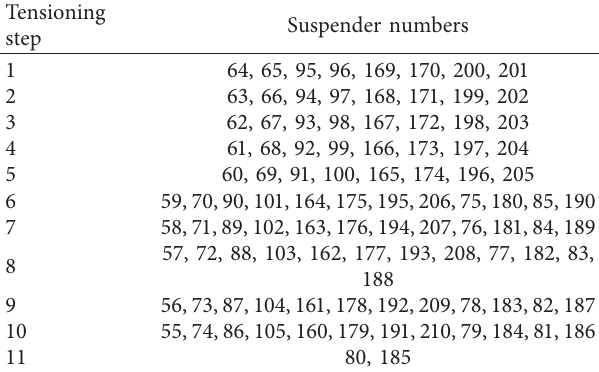
Table 3: Tensioning